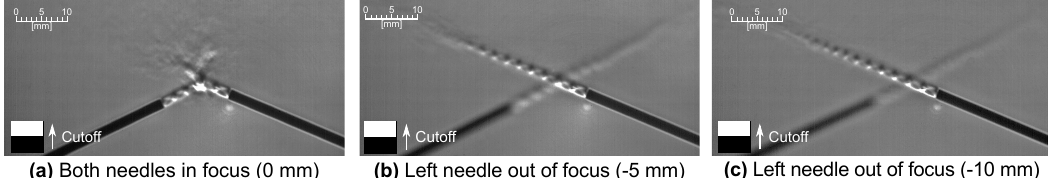
Figure 4. Experimental validation of DOF by means of two crossed under-expanded jets. The outer diameter of the hypodermic needles was 1.5mm. The left needle was traversed along the optical axis (perpendicular to the image plane).